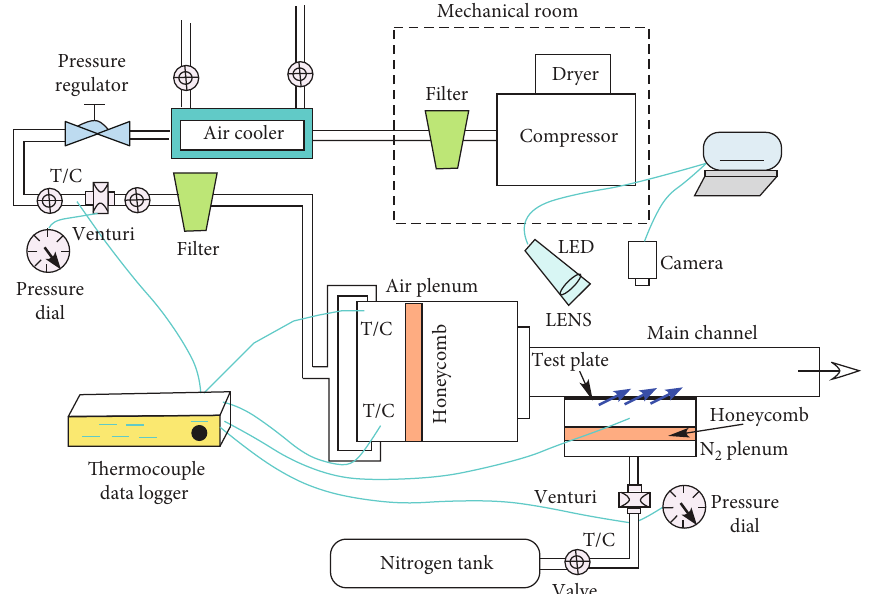
Figure 1: Test rig, associated accessories, and data collection equipment.